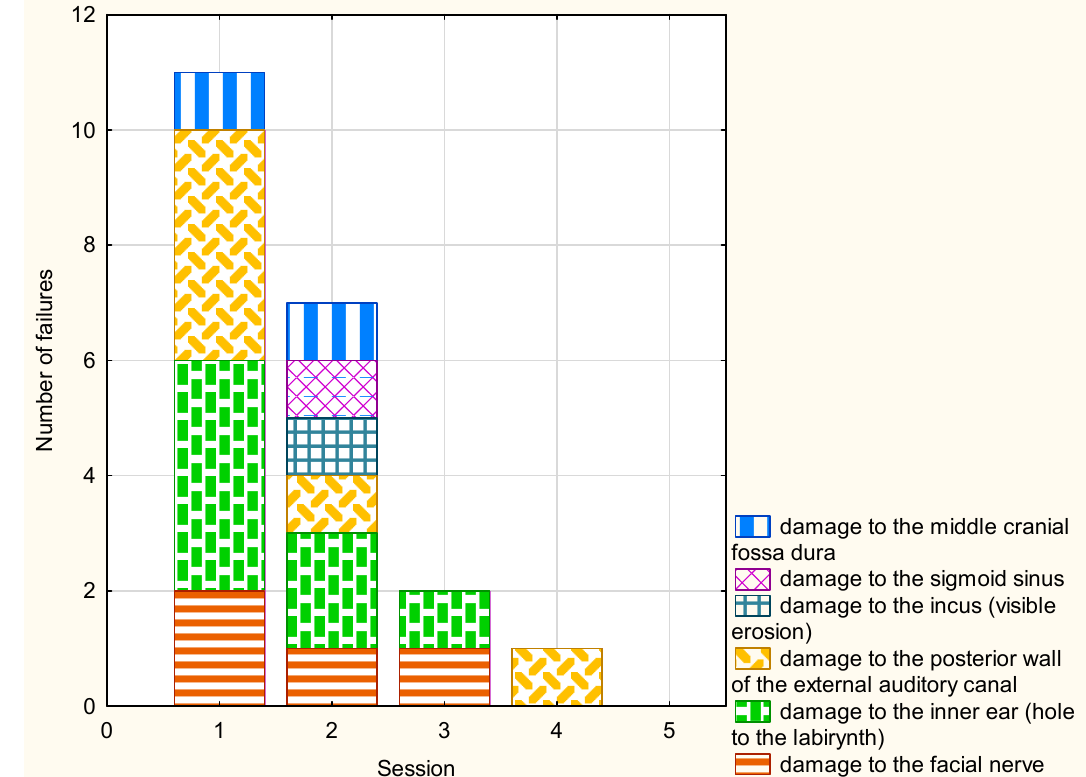
Figure 4. The number and characteristics of the failures during VR